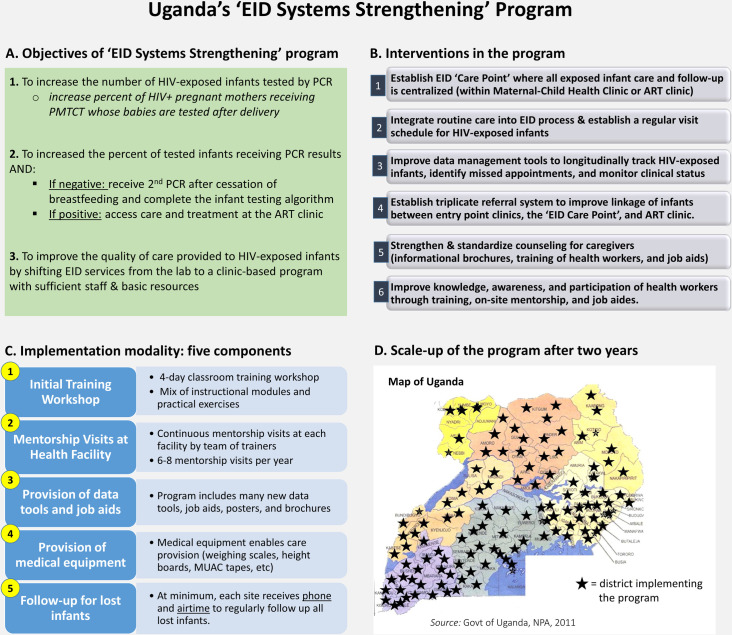
Uganda’s ‘EID Systems Strengthening’ program.A—Objectives of ‘EID Systems Strengthening’ program. B—Interventions in the program. C—Implementation modality: five components. D—Scale-up of the program after two years. Map source: Government of Uganda, National Planning Authority (NPA), 2011. Abbrev: EID = Early Infant Diagnosis, PMTCT = Prevention of Mother-to-Child Transmission, PCR = Polymerase Chain Reaction, MUAC = Mid-upper Arm Circumference.